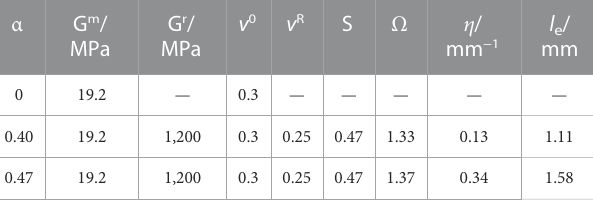
TABLE 3 The parameters of the mesomechanism based shear strength model of soil-rock mixture. α G m / G r MPa